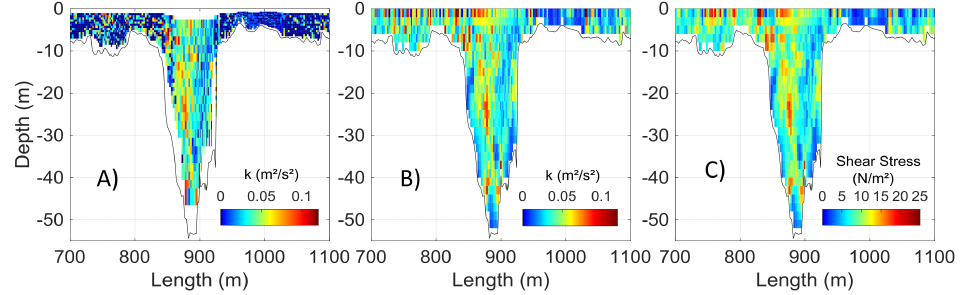
Figure 7. Turbulent kinetic energy (k) before ( A ) and after ( B ) vertical interpolation; ( C ) Shear-stress distribution using the TKE method.